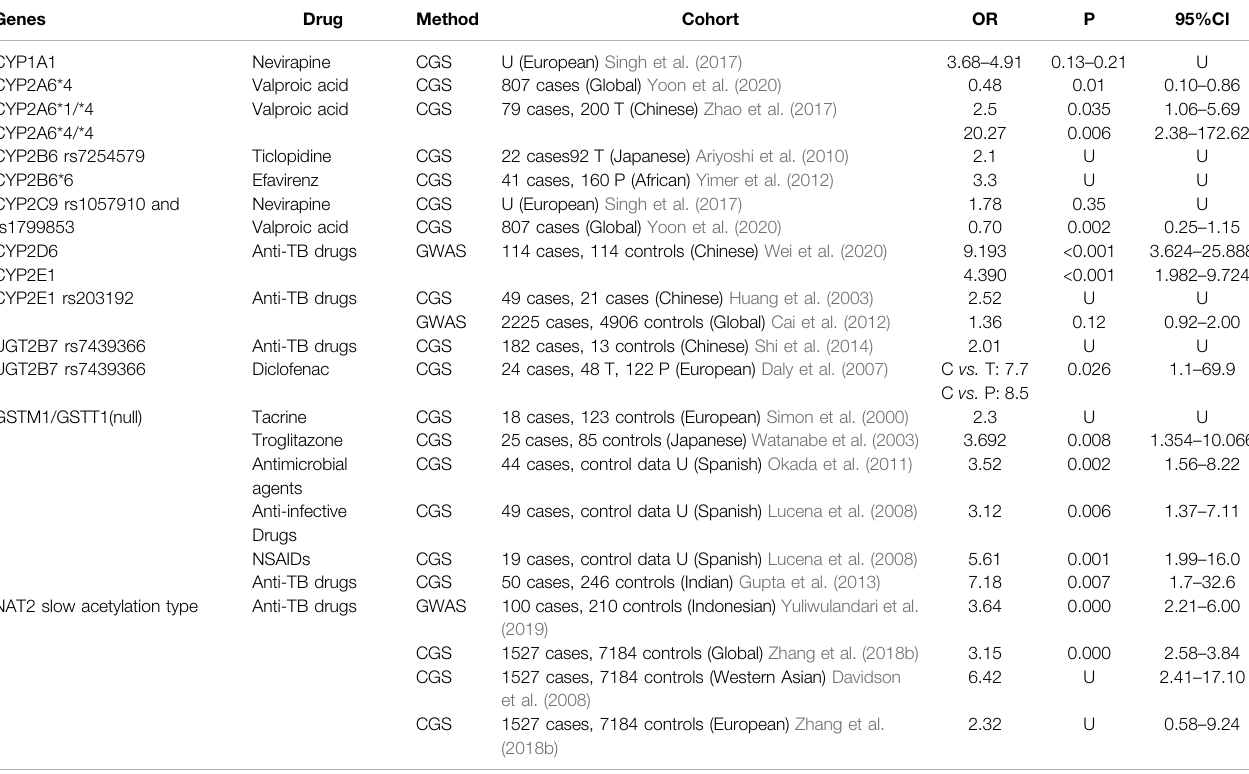
TABLE 2 | Polymorphisms of DILI-related drug metabolizing enzymes genes identi fi ed in GWAS and CGS.